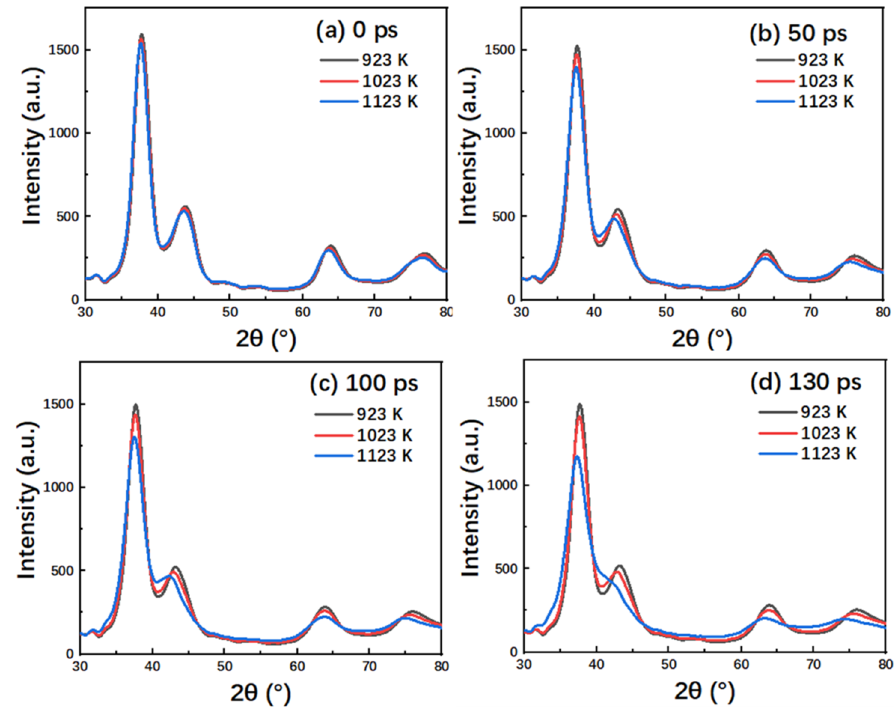
Figure 4. The simulated XRD pattern of a representative nanocrystalline TiAl model with 4.6 nm grain size during creep deformation for ( a ) 0, ( b ) 50, ( c ) 100, ( d ) 130 ps under the stress levels of 1.4 GPa at 923 K, 1023 K, and 1123 K.